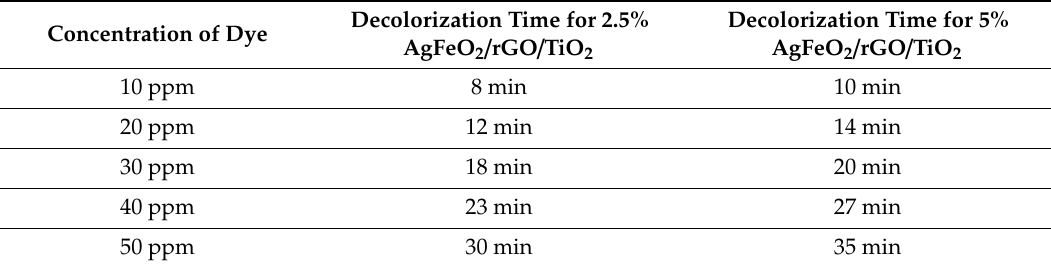
Table 2. Decolorization time for di ff erent MB Dye with various